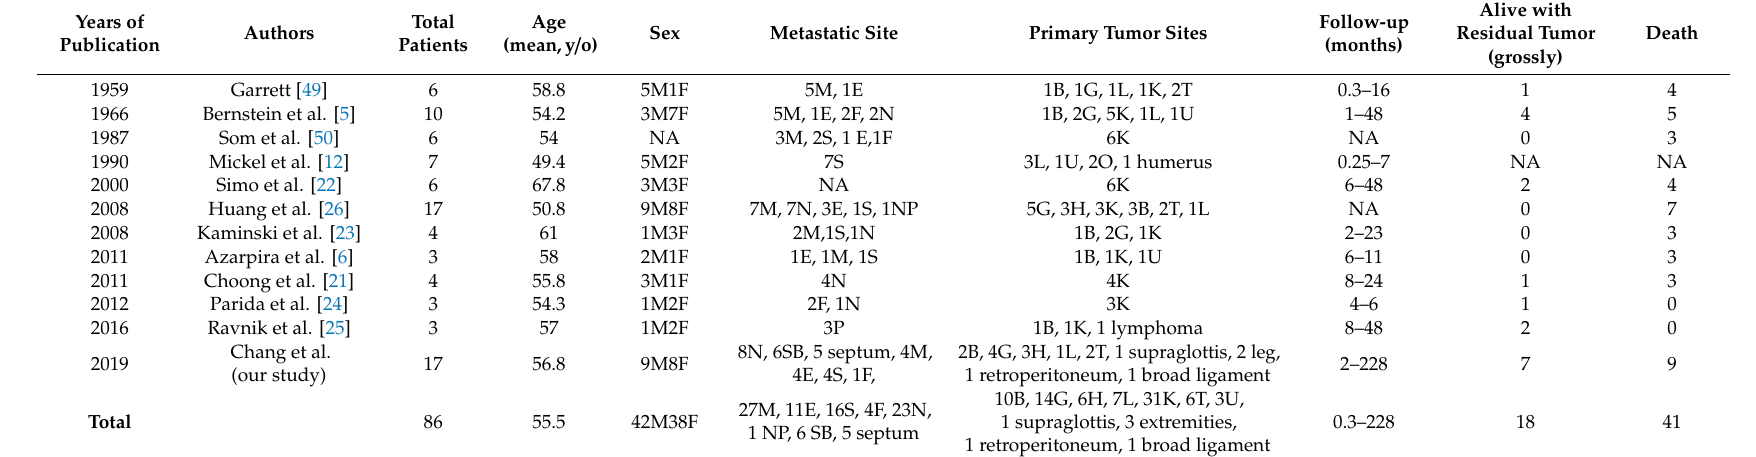
Table 4. Review of major case series (cases ≥ 3) of sinonasal metastatic cancers in the English language